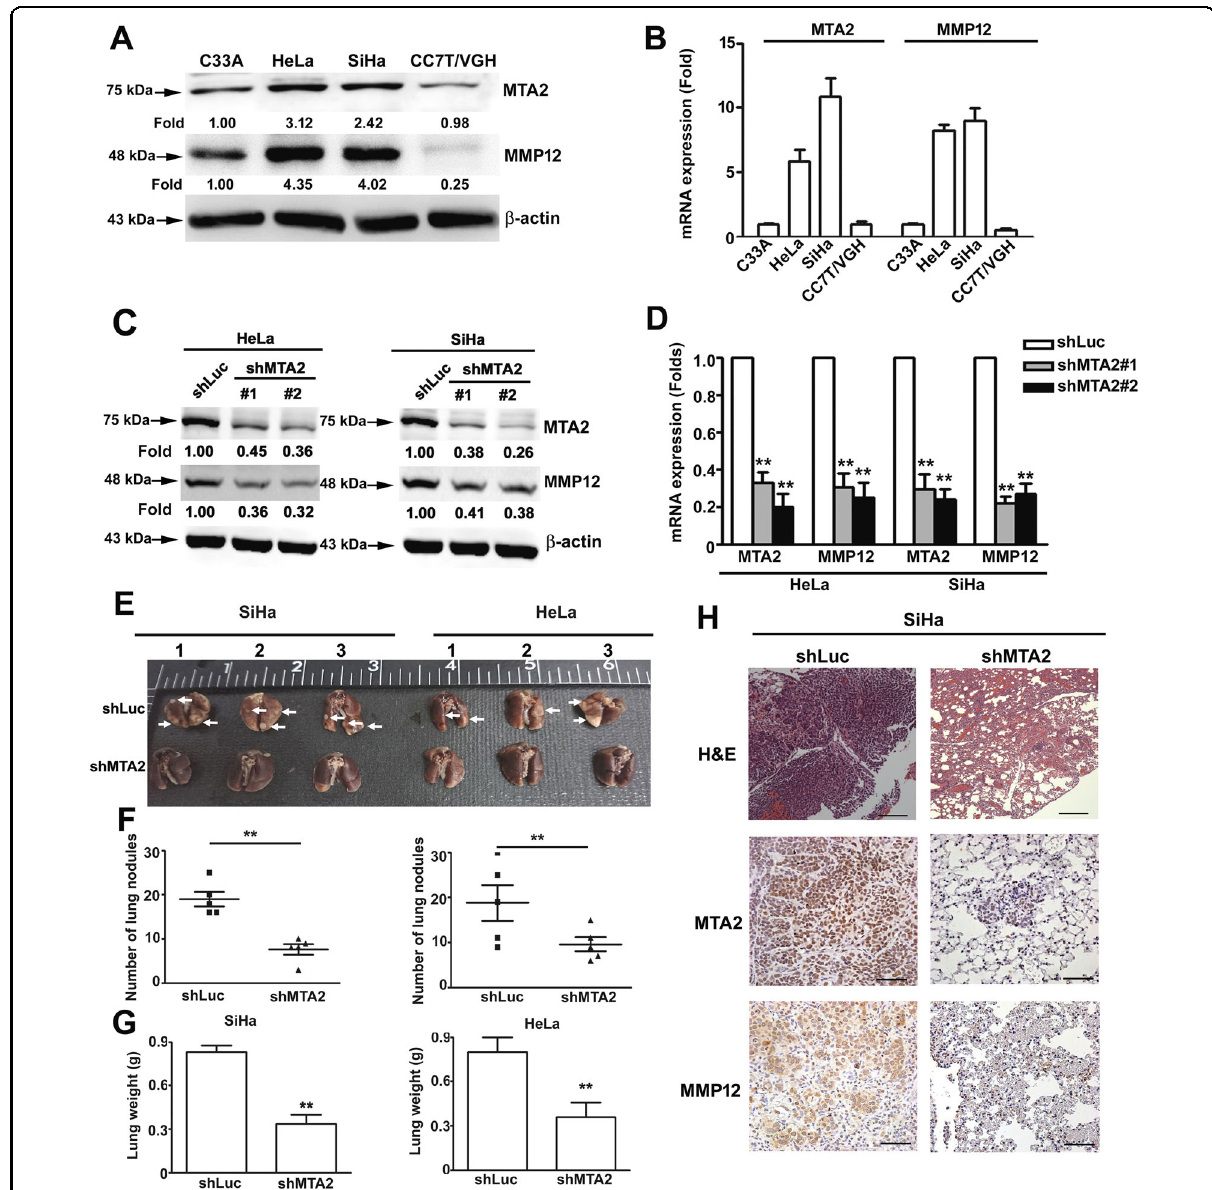
Fig. 1 MTA2 expression in human cervical cancer cells and its correlation with MMP12 and cervical cancer lung metastasis. (A) Protein level of MTA2 and MMP12 in human cervical cancer cells as determined by Western blot. ( B) mRNA expression of MTA2 and MMP12 in human cervical cancer cells as determined by qRT-PCR. ( C) Protein level of MTA2 and MMP12 in MTA2-knockdown HeLa and SiHa cells as determined by Western blot. ( D) mRNA expression of MTA2 and MMP12 in MTA2-knockdown HeLa and SiHa cells as determined by qRT-PCR. ( E – H) MTA2-knockdown cells were subjected to in vivo xenograft analysis for assessment of ( E ) lung metastasis, ( F ) numbers of lung nodules, ( G ) weights of lungs, and ( H ) histological change in lung tissues as indicated by IHC staining. ** P < 0.01 compared with the shLuc cells or